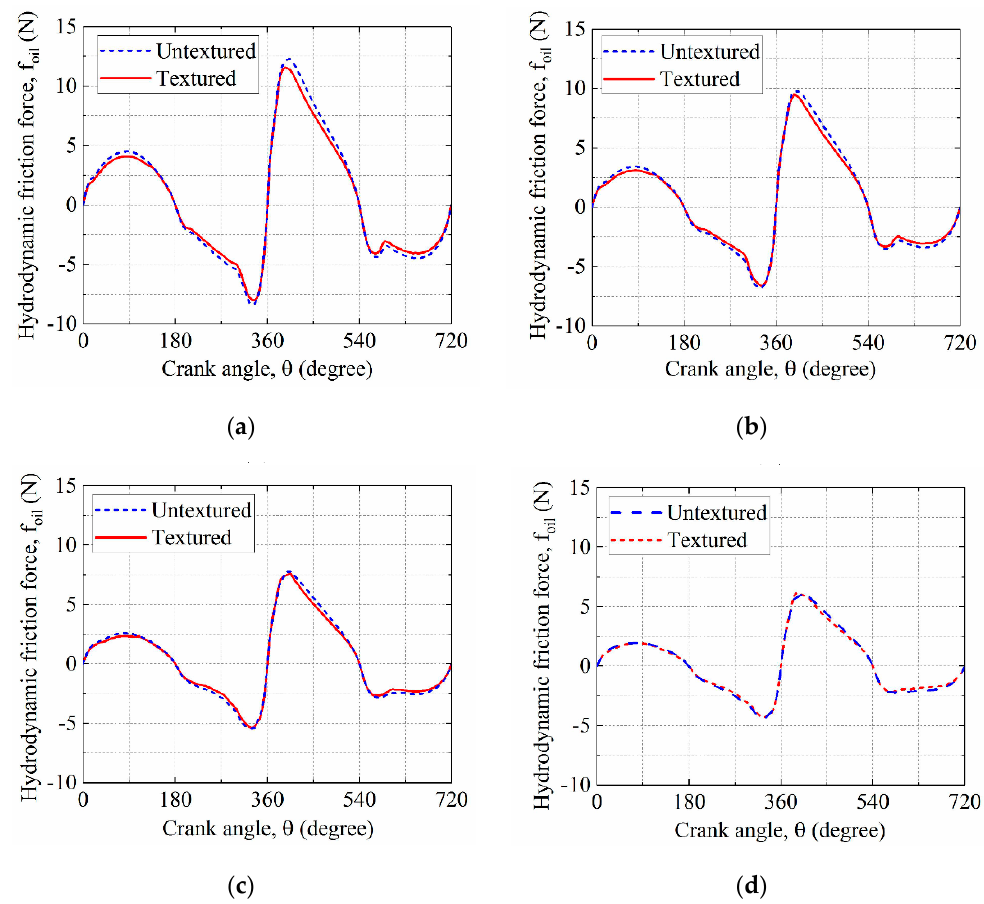
Figure 15. Hydrodynamic friction forces of the textured RLC and untextured RLC: ( a ) T liner is 60 °C; ( b ) T liner is 80 °C; ( c ) T liner is 100 °C; and ( d ) T liner is 120 °C.